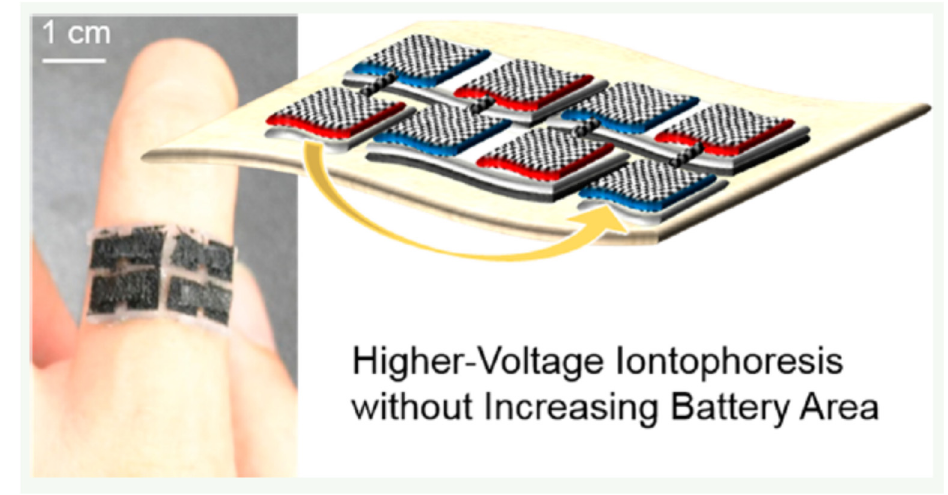
Figure 8. The series connection of EBFC [86]. Copyright 2020 ACS Publication.